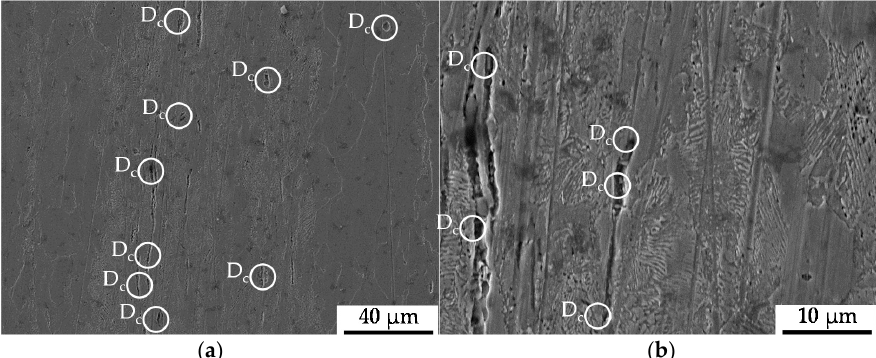
Figure 9. Material reaction under cyclic tension ( R = 0.1) and cyclic compression–tension ( R = − 1) load conditions obtained longitudinal to, viz. in, the extrusion direction (l) after the load increase test (LIT). Materials 2020 , 13 , x FOR PEER REVIEW